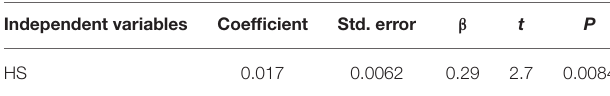
TABLE 4 | Hidden relationships detected by the factor analysis. TABLE 5 | Prediction of IMT by HS of the univariate